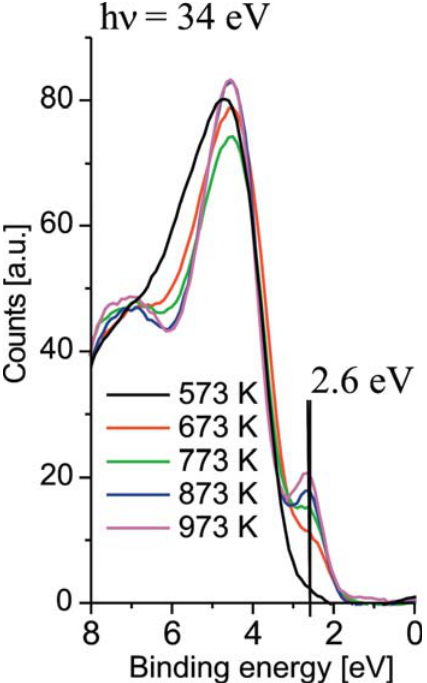
Figure 9 . Evolution of the valence band spectrum of the SnO temperature. Above 600 K a band gap state develops at a binding energy of 2.6 eV. This band gap state is associated with Sn-5s electrons that become occupied as the surface reduces to form a Sn(II) surface